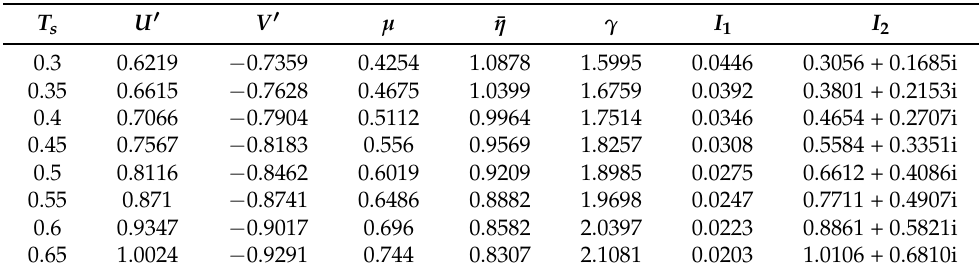
Table 1. Values of stability parameter for a rotating disk in axial flow T s > 0.25.